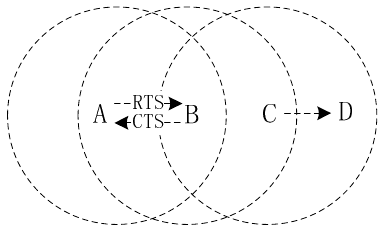
Figure 1. The example of hidden terminals.